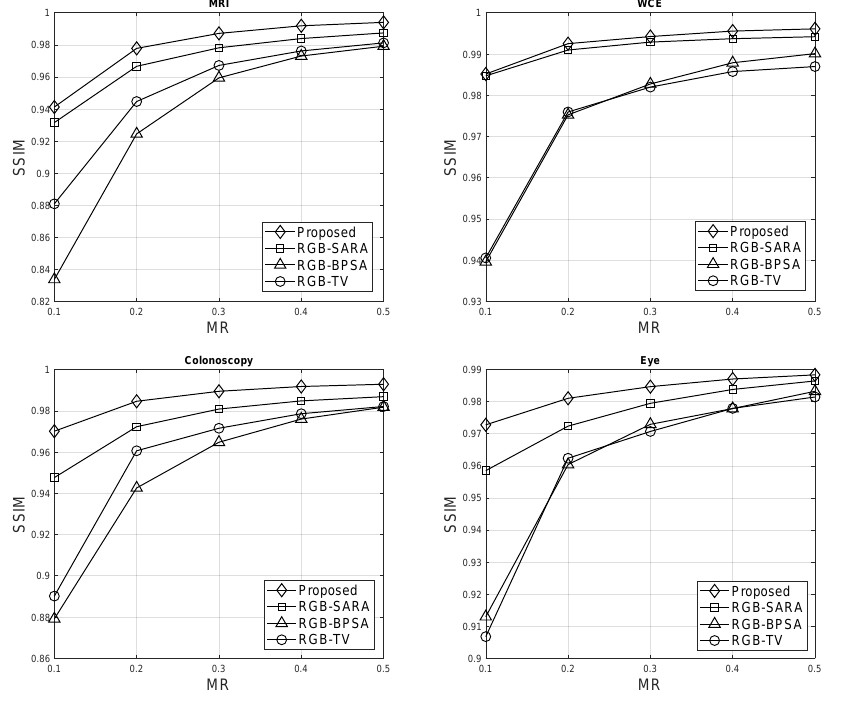
Figure 6. SSIM results. Table 4. SSIM